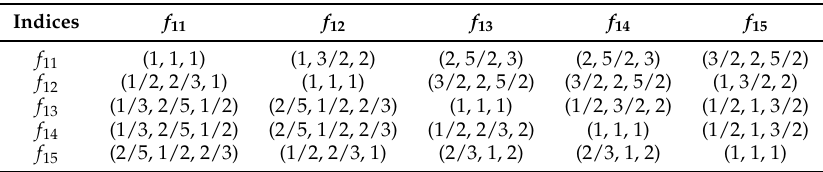
Table A1. Fuzzy comparison matrix of the indices of DGA.